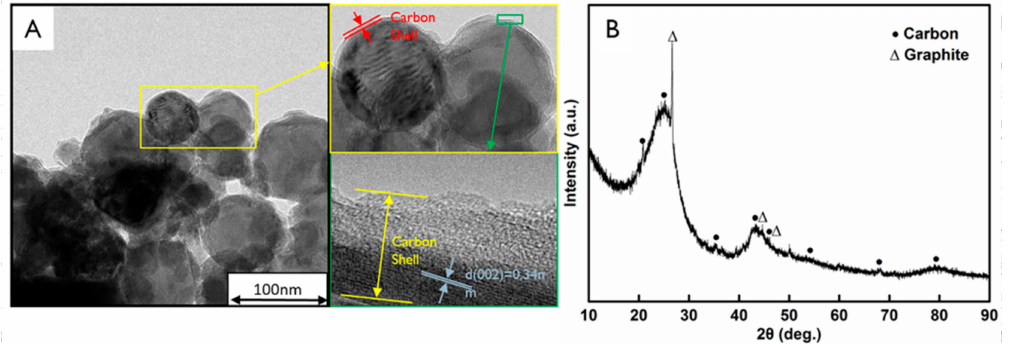
Figure 5. ( A ) High-resolution TEM images of the AlTi-MgO@C NP and ( B ) XRD pattern of the AlTi-MgO NP after HCl acid pickling for 30